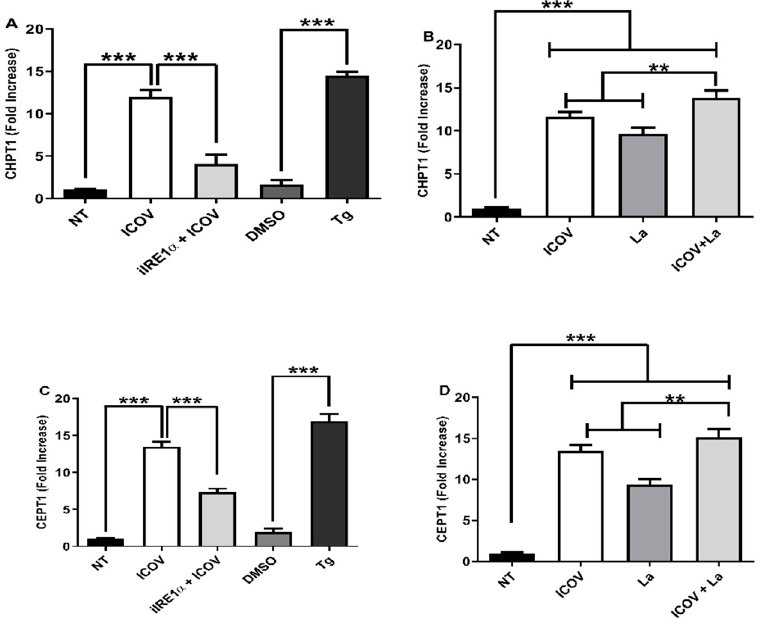
Figure 4. Upregulation of XBP1 dependent genes during ICOV and ICOV/ L. amazonensis coinfection. CHPT1 ( A , B ) or CEPT1 ( C , D ) transcript levels were measured by qRT-PCR normalized to GAPDH transcript levels after 6 h of treatment and/or infections. Peritoneal macrophages from C57BL/6 mice were not treated (NT), infected with Phlebovirus Icoaraci (ICOV) at MOI 1, pre-treated with 100 nM of IRE1a inhibitor during 1 h, followed by ICOV infection or treated with 1 µ M Tapsigargin (TG) or DMSO ( A , C ). The same analysis was done during ICOV/ L. amazonensis coinfection ( B , D ). Asterisks indicate significant differences with ** p < 0.001 or *** p < 0.0001.